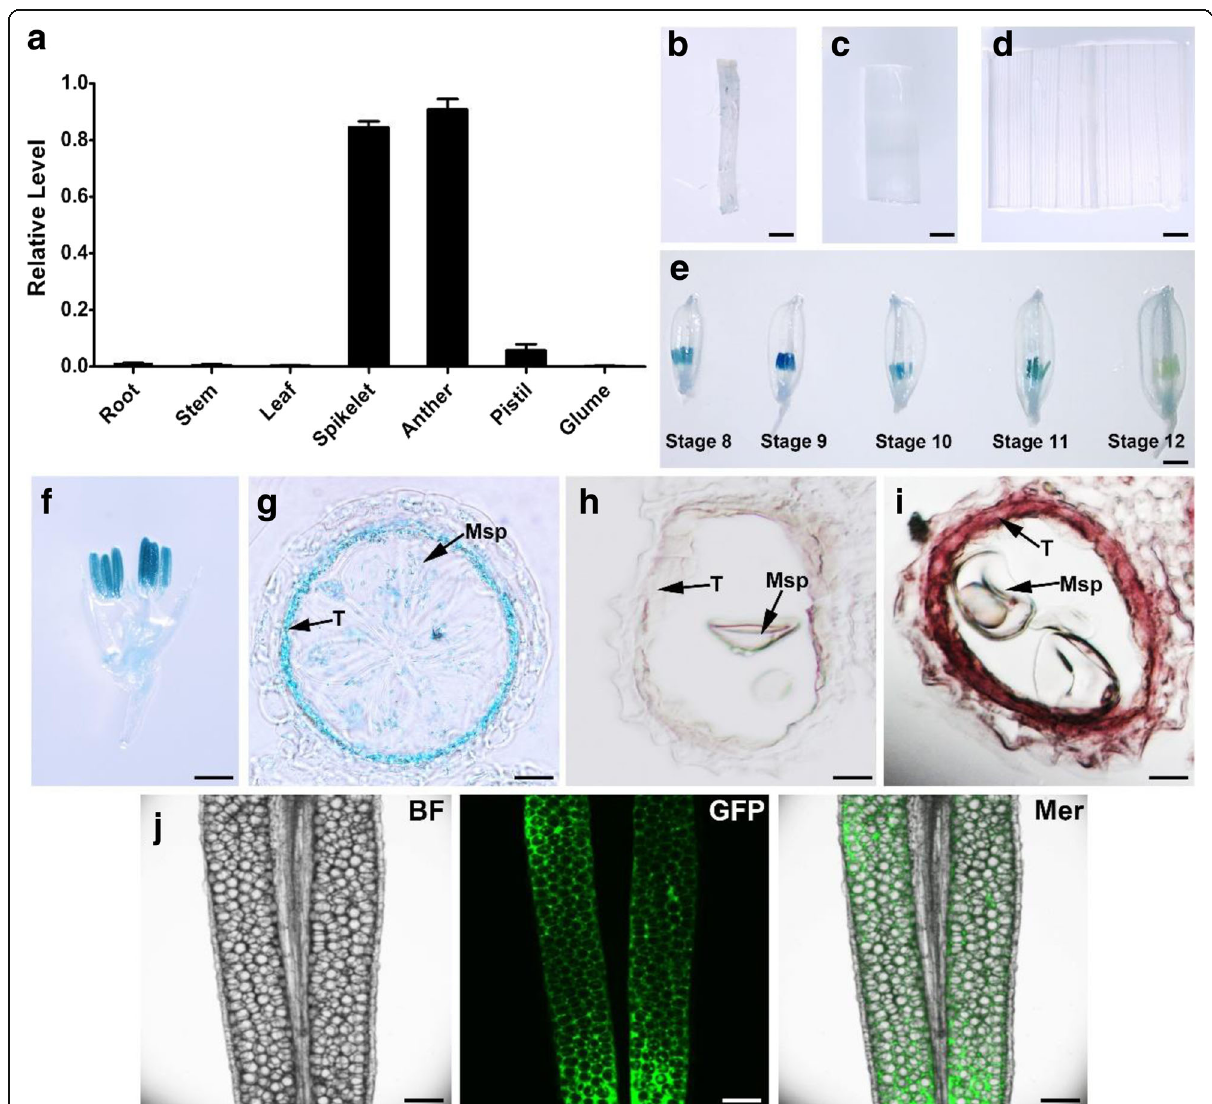
Fig. 5 Expression pattern of OsLAP6/OsPKS1 . a Expression analysis of OsLAP6/OsPKS1 by qPCR. b - g GUS expression (blue staining) patterns of root, stem, leaf, spikelet at different anther developing stages, spikelet with the palea and lemma removed at stage 9, and the section of GUS-staining anther of the OsLAP6/OsPKS1 pro ::GUS transgenic line, respectively. h and i RNA in situ hybridization of OsLAP6/OsPKS1 sense and antisense probe with the WT (Nipponbare) sections, respectively. j Confocal images of the hand free anther samples of OsLAP6/OsPKS1 pro ::OsLAP6/OsPKS1-GFP transgenic line. BF, bright field; GFP, green fluorescent protein channel; Mer, merged image of each channel. Msp, microspore; T, tapetum. Scale bars = 1 mm ( b - g ); 20 μ m ( h - i ); 50 μ m ( j